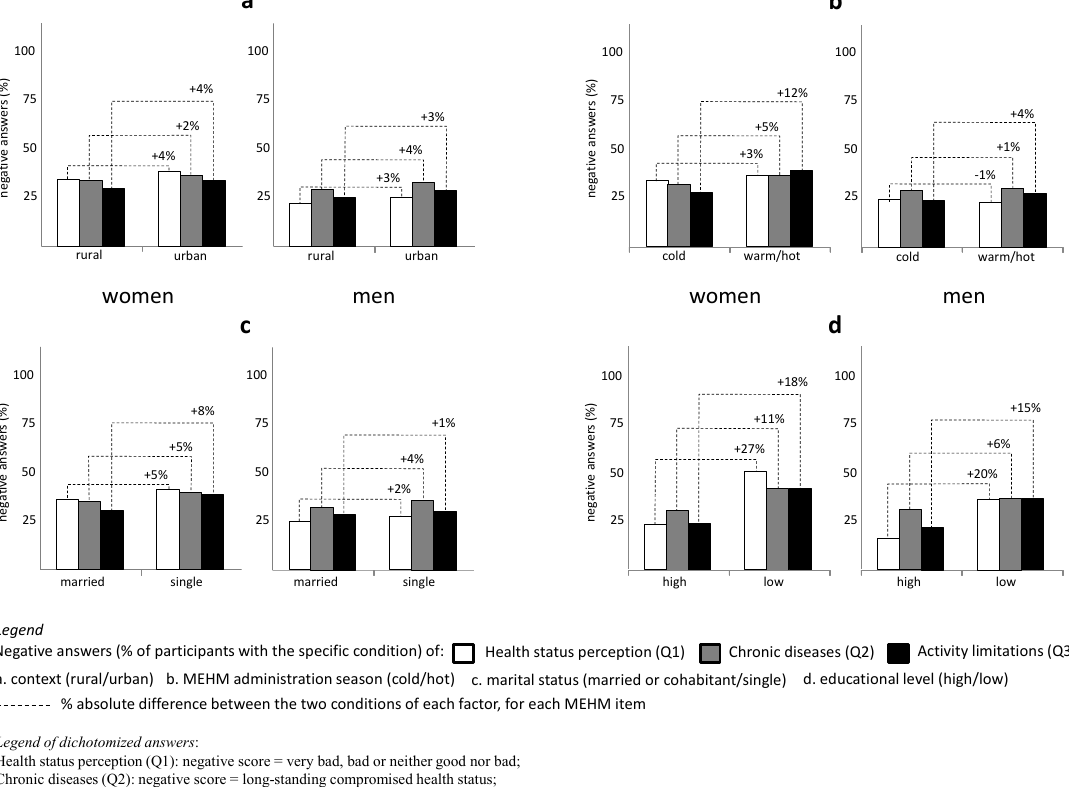
Figure 2. Negative score (%) of MEHM items in association with living context ( a ), seasonality (namely, the season in which the MEHM questionnaire was administered) ( b ), marital status ( c ) and level of education ( d ), each factor accounted individually and separately plotted for men and for women. Plots are referred to dichotomized variables (data source: the CUORE Project Health Examination Survey 2008–2012, Italian men and women, 35–79 years old).